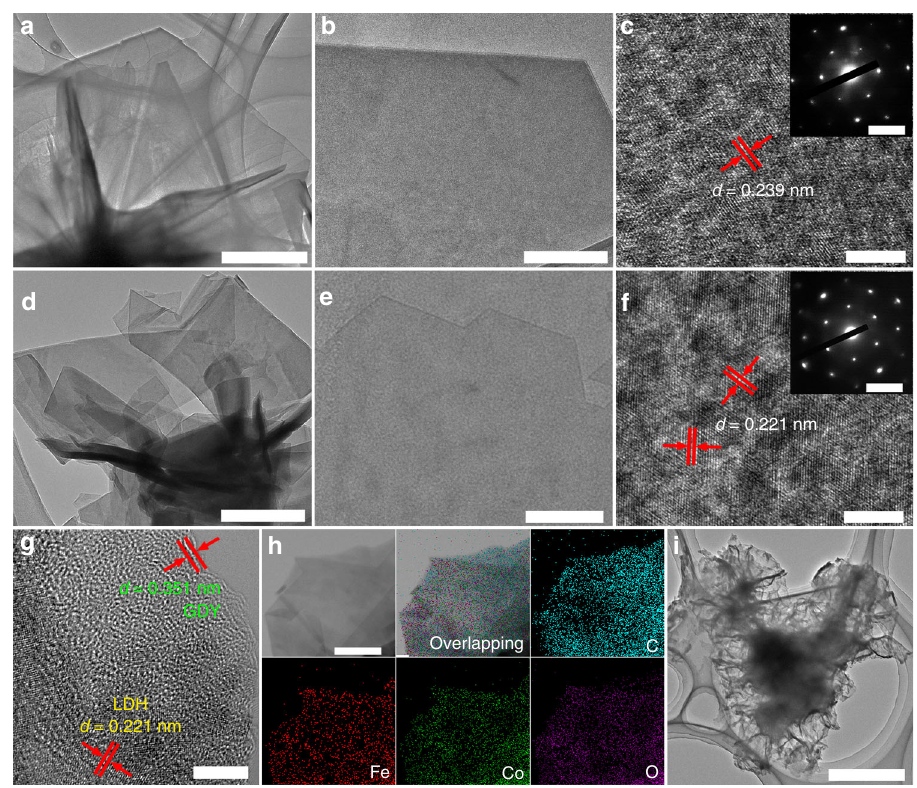
Fig. 3 TEM characterization of electrocatalyst samples. a Low-magni fi cation, b high-magni fi cation, and c high-resolution TEM images and corresponding selected-area electron diffraction pattern (SAED, inset to c of pure ICLDH nanosheets. Scale bars: a 1 μ m; b 300 nm; c 5 nm; inset of c , 5 1/nm. d Low- magni fi cation, e high-magni fi cation, and f , g high-resolution TEM images of e-ICLDH@GDY nanosheets (inset to f SAED pattern of e-ICLDH@GDY). Scale bars: d 200 nm; e 100 nm; f and g 5 nm; inset of f 5 1/nm. h Typical scanning TEM and corresponding elemental mapping images of C, Fe, Co, and O atoms in the e-ICLDH@GDY nanosheets. Scale bars: h 100 nm. i TEM image of the GDY coatings after removal of the ICLDH from the sample. Scale bars: i 500